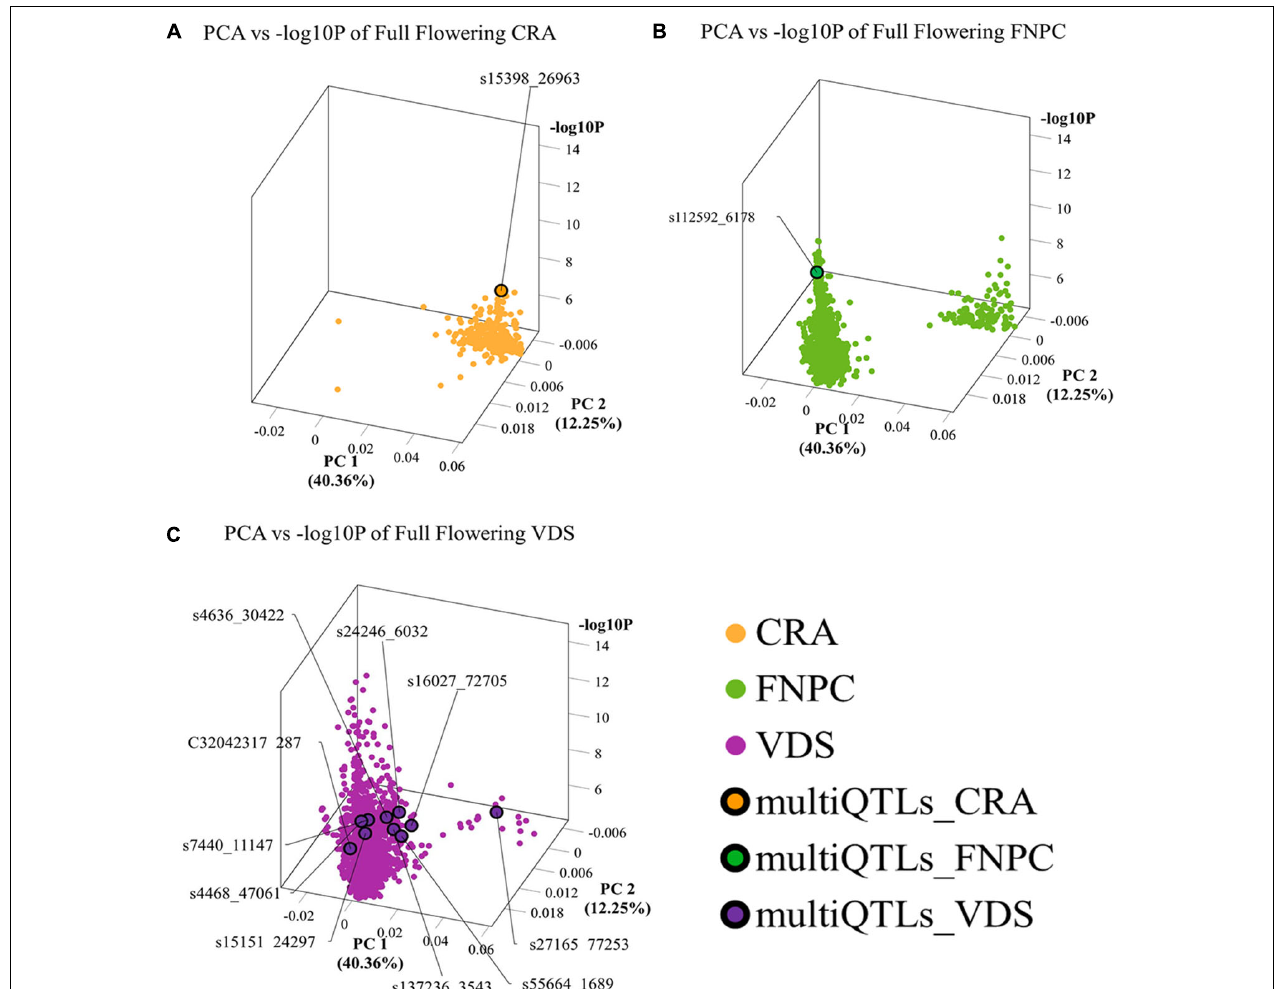
FIGURE 3 | 3D scatter plots of PCAs depicting clustering of significant markers on basis of variation in the allele frequency profiles in the mapping population and significance in GWAS, for, respectively, full flowering in CRA (A) , full flowering in FNPC (B) , and full flowering in VDS (C) . X -axes indicate Principal Component 1, Y -axes indicate Principal Component 2, and Z -axes indicate the significant level of the association (–log 10 P). Orange, green, and purple dots indicates the significant markers detected in CRA, FNPC, and VDS, respectively. Orange, green, and purple dots with a black circle represent the representative QTL-markers of the MultiQTL models from CRA, FNPC, and VDS,